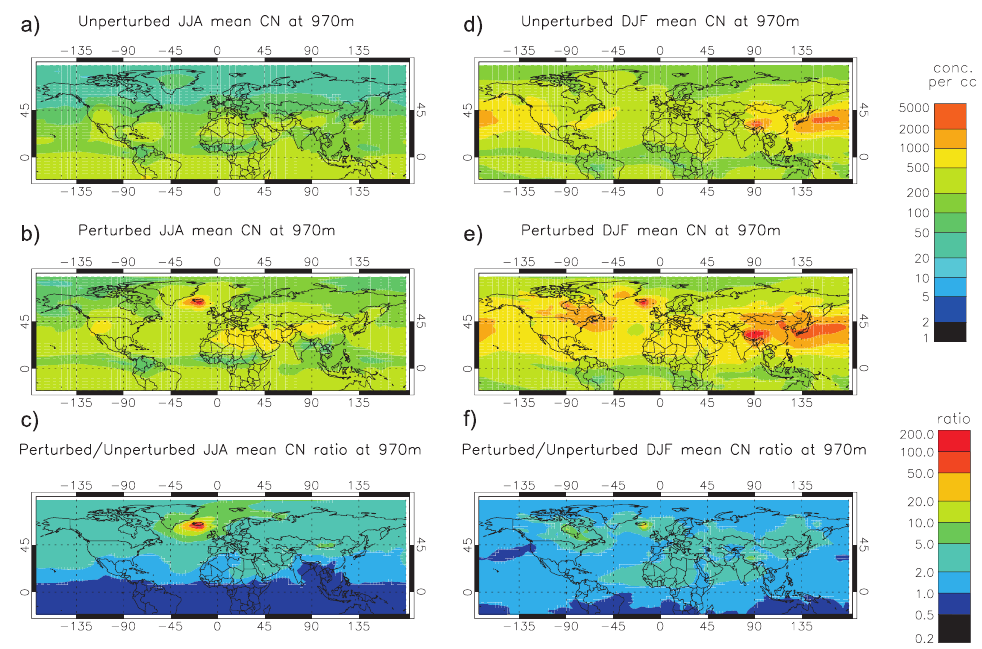
Fig. 10. Simulated 3-month mean CN concentrations per cubic centimeter (per cc) at 970m altitude for L-s: (a) unperturbed run, (b) per- turbed run, (c) ratio of perturbed to unperturbed; and for L-w: (d) unperturbed run, (e) perturbed run, (f) ratio of perturbed to unperturbed. JJA=June-July-August; DJF=December-January-February.